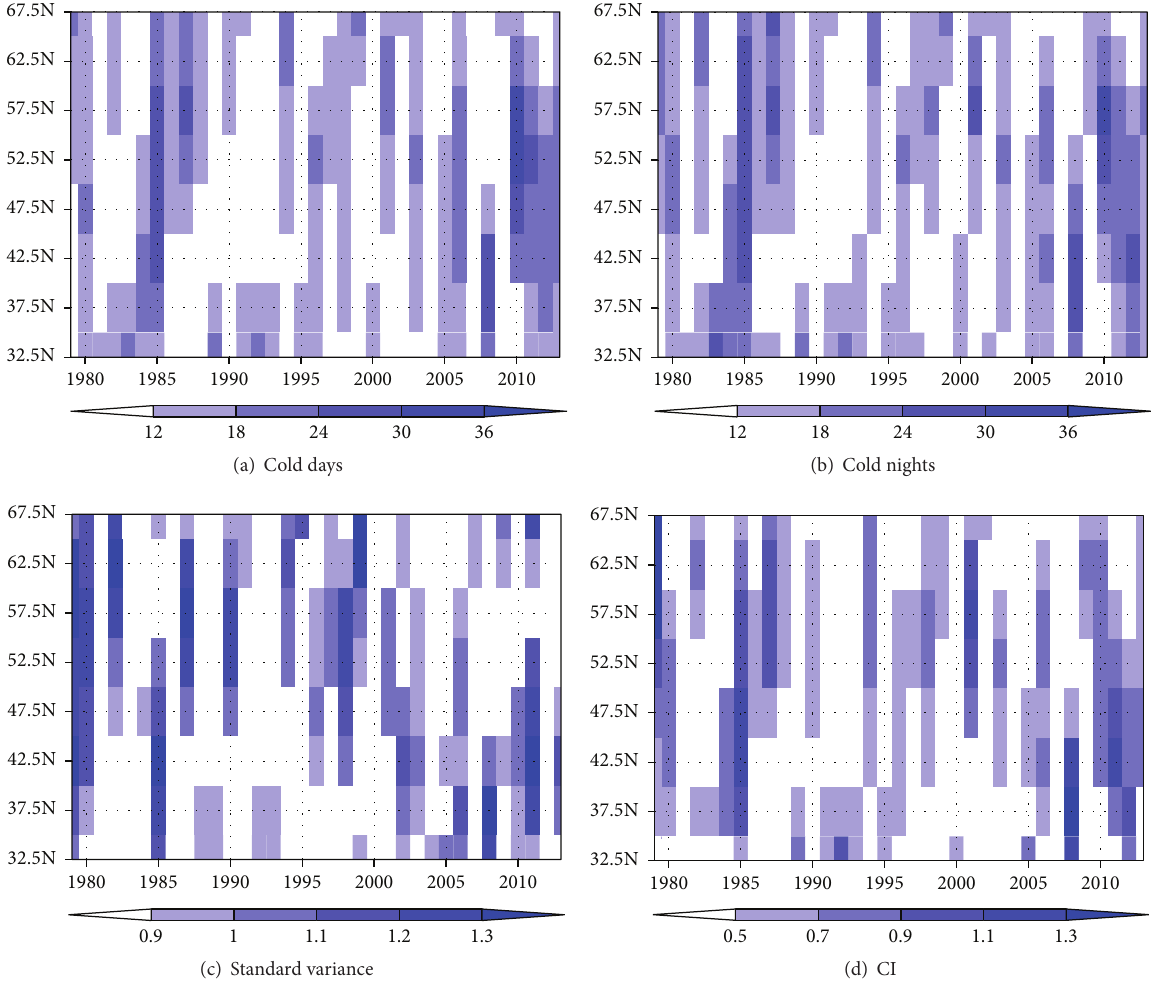
Figure 1: Changing extreme cold events, 925 hPa temperature variability, and CI. Zonal mean (0 ∘ –180 ∘ E) winter cold days ((a) unit: days), cold nights ((b) unit: days), intraseasonal variance (c), and CI (d) during 1979–2013. The values are calculated at each grid point before area averaging for 5 ∘ latitude bands from 30 ∘ N to 70 ∘ N. The 1979–2013 mean is used as the climatological value in (d). The units for (a) and (b) are